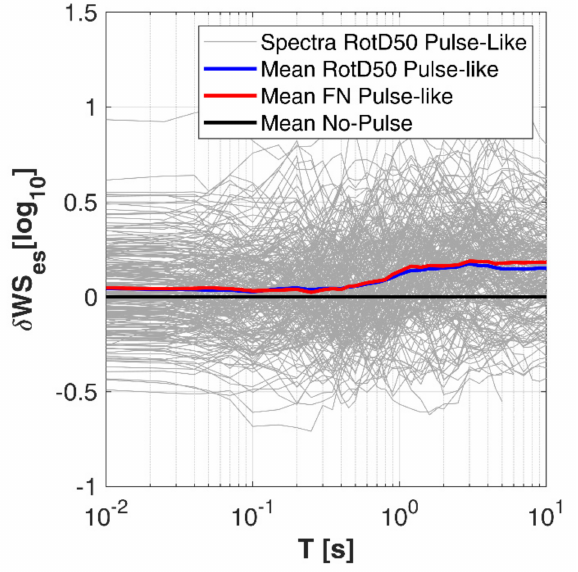
Figure 8. Individual and mean within-event residual values for pulse-like and no-pulse ground motions in